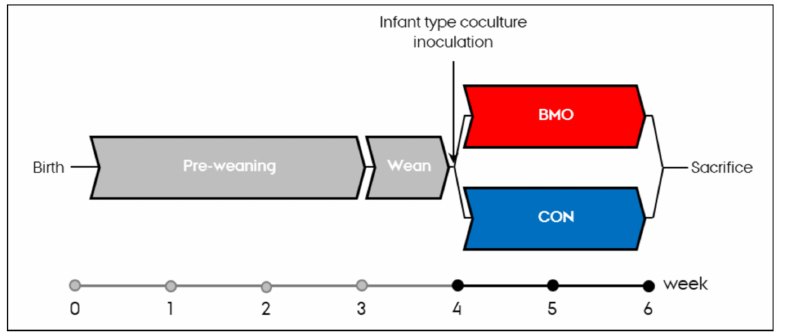
Figure 1. Study design of the gnotobiotic mouse study showing the time from birth, pre-weaning, weaning, experimental period until sacrifice. BMO: synthetic diet containing 2% ( w/w ) bovine milk oligosaccharides. CON: synthetic control